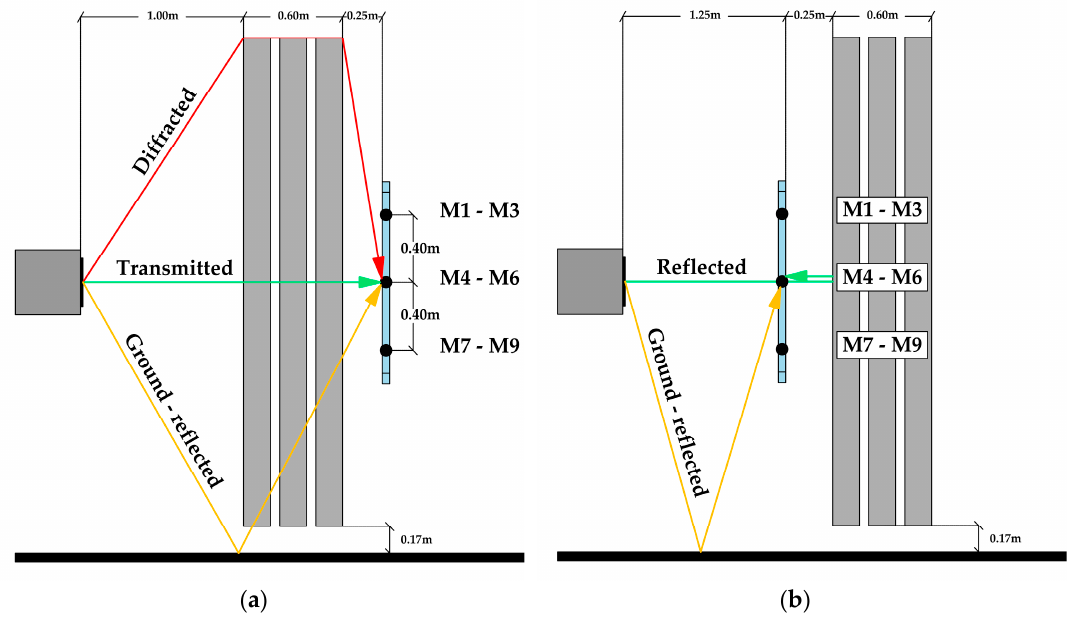
Figure 3. Illustration of standardised EN 1793-5 and EN 1793-6 measurement methods in the presence of the SC barrier: ( a ) Experimental setup for SI measurement; ( b ) experimental setup for RI measurement.